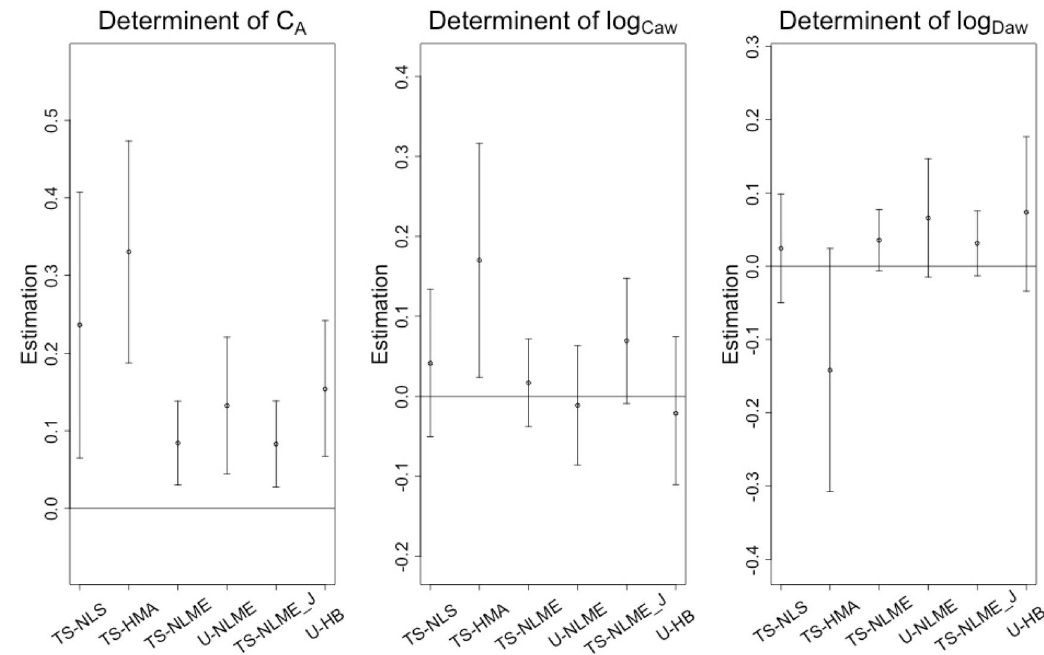
Figure 4. Analysis of CHS data: estimated associations of traffic-related air pollution with C A , logC aw , and β and 95% CI) using the selected methods, *with no adjustments for covariates. *TS-NLME ( J ′ logD aw ( ′ previously published model using a J aw parameterization of (cid:31)